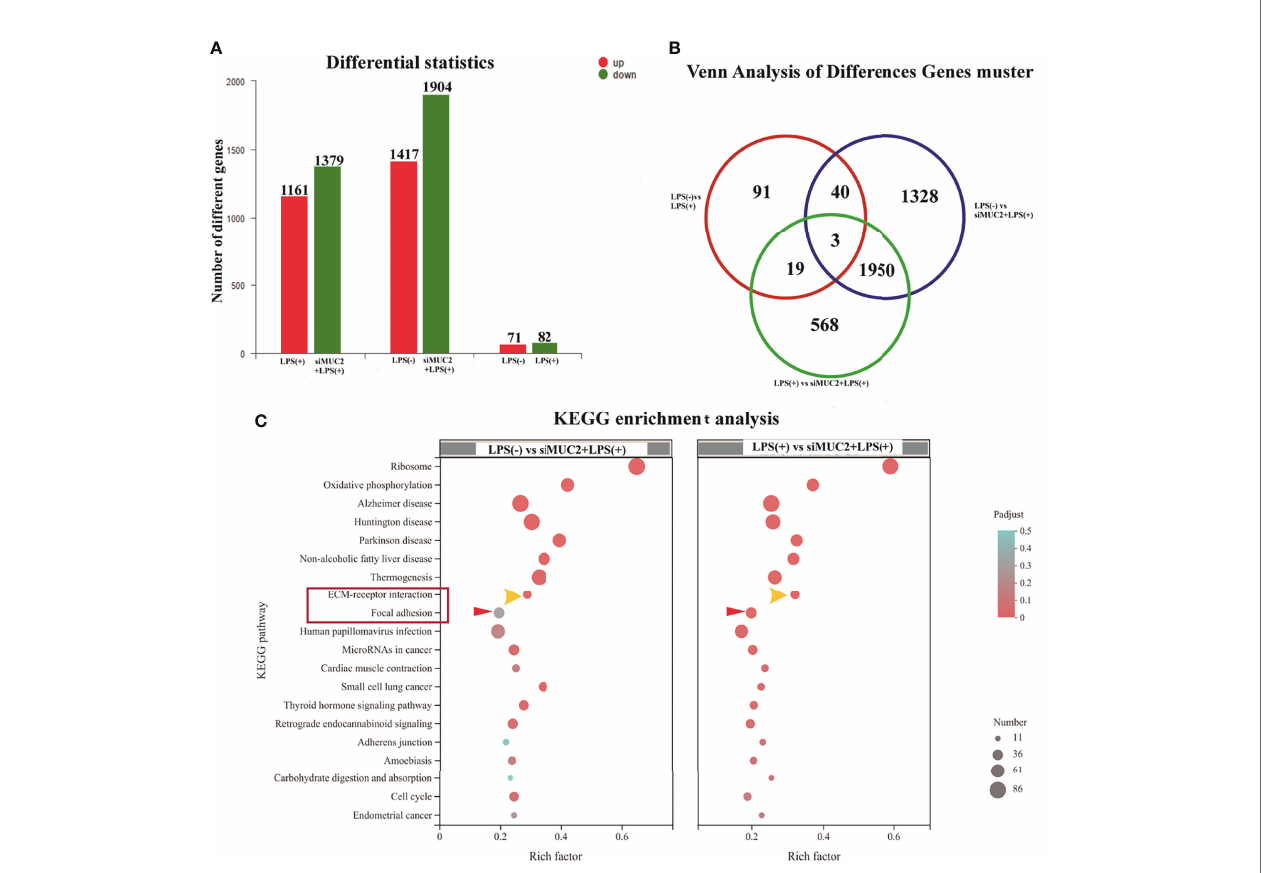
FIGURE 4 | RNA-seq of the LPS(+) group, LPS(-) group, and siMUC2+LPS(+) group. (A), the number of different genes in the LPS(+) vs siMUC2+LPS(+) group, LPS(-) vs siMUC2+LPS(+) group, and LPS(-) vs LPS(+) group; red color indicated upregulated gene and blue color indicates downregulated gene (N=6); (B) , Venn analysis of different gene clusters in the LPS(+) vs siMUC2+LPS(+) group, LPS(-) vs siMUC2+LPS(+) group, and LPS(-) vs LPS(+) group; Three genes were found between the LPS(+) vs siMUC2+LPS(+) group, LPS(-) vs siMUC2+LPS(+) group, and LPS(-) vs LPS(+) group; 43 genes were found between the LPS(-) vs siMUC2 +LPS(+) group and LPS(-) vs LPS(+) group; 22 genes were found between the LPS(-) vs LPS(+) group and LPS(+) vs siMUC2+LPS(+) group; and 1,953 genes were found between the LPS(+) vs siMUC2+LPS(+) group and LPS(-) vs siMUC2+LPS(+) group (N=6); (C), KEGG enrichment analysis of the LPS(+) vs siMUC2+LPS(+) group (right column) and LPS(-) vs siMUC2+LPS(+) group (left column); the fi rst 20 signaling pathways with differentially expressed genes are listed in the fi